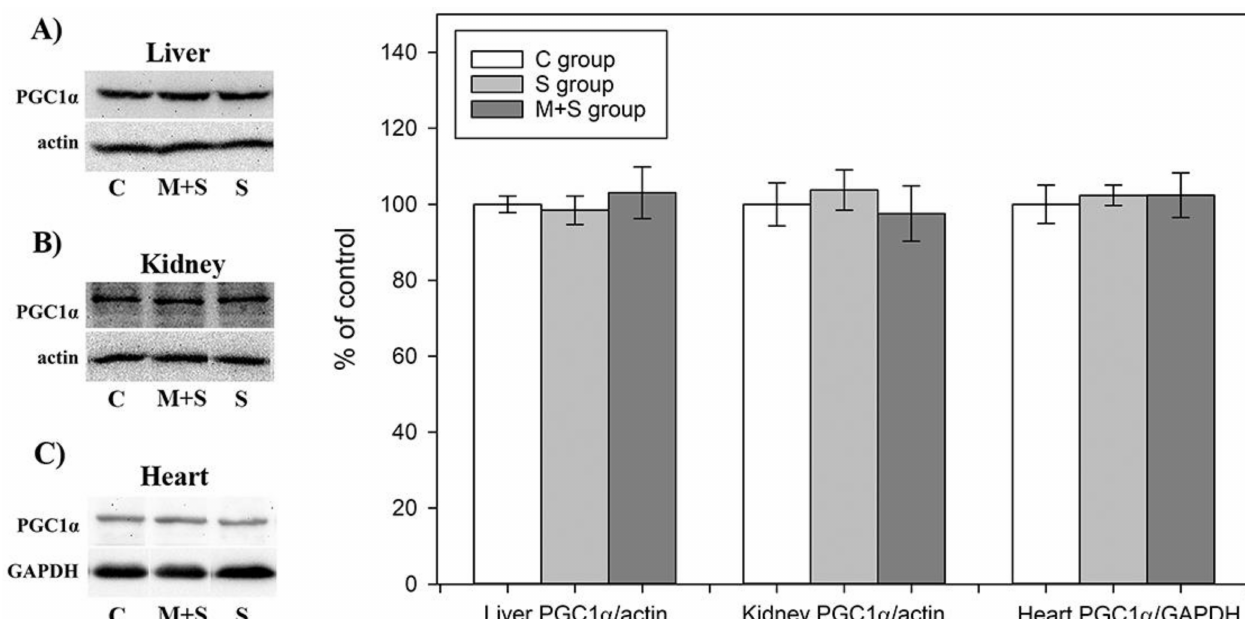
Figure 5. Representative immunoblots of protein expression levels of peroxisome proliferator-activated receptor gamma coactivator 1-alpha in the: ( A ) liver; ( B ) kidney; and ( C ) heart in rats of control (C), sepsis (S), and meldonium + Sepsis (M + S) groups. β actin was used as a loading control for the liver and kidney, while glyceraldehyde 3-phosphate dehydrogenase (GAPDH) was used as a loading control for the heart. Protein expression levels are calculated and graphically presented as the percent of control (mean ± standard error). Note: tissue samples were loaded on the gels in the groups order C, M + S, and S (blots presented on the left side of the figures), whereas calculated protein expression levels were graphically presented in the groups’ order C, S, and M + S (graphs presented on the right side of the figure). Minimal significance level: p <